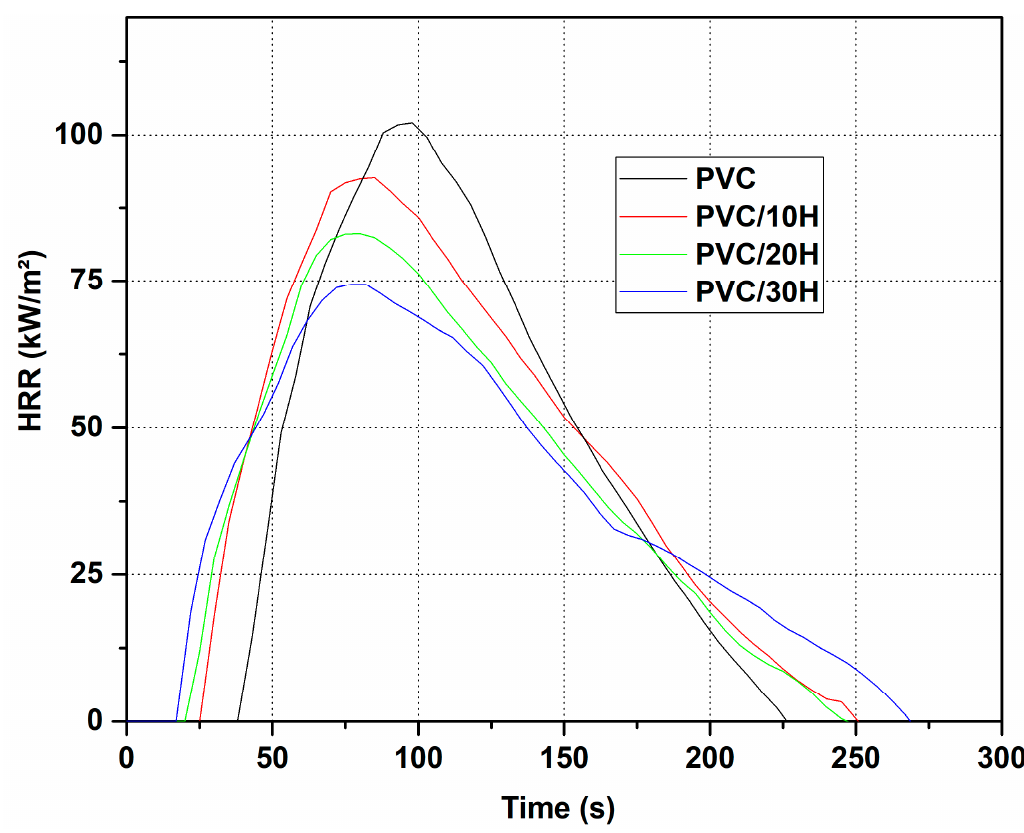
Figure 11. HRR vs. time for PVC and PVC composites.